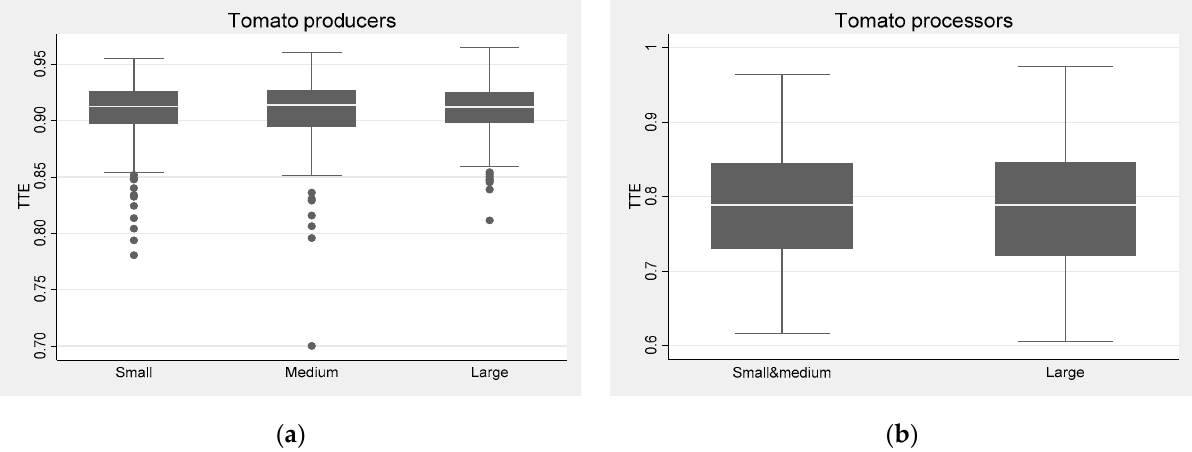
Figure 5. Development of technical efficiency. Source: authors’ calculations.